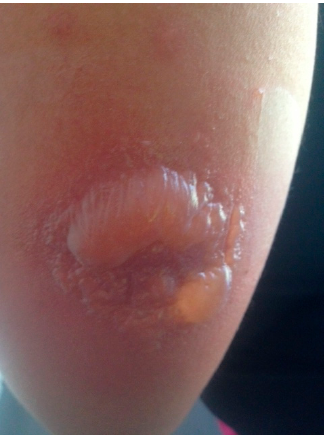
Figure 2. Day 5 after inoculation, the reaction site with multiple vesicles coalescing into a primary 4 cm bulla.